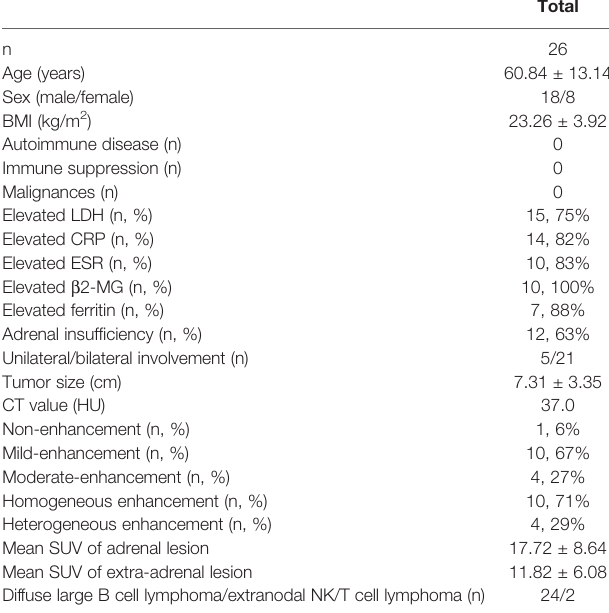
TABLE 1 | Clinical characteristics of the study